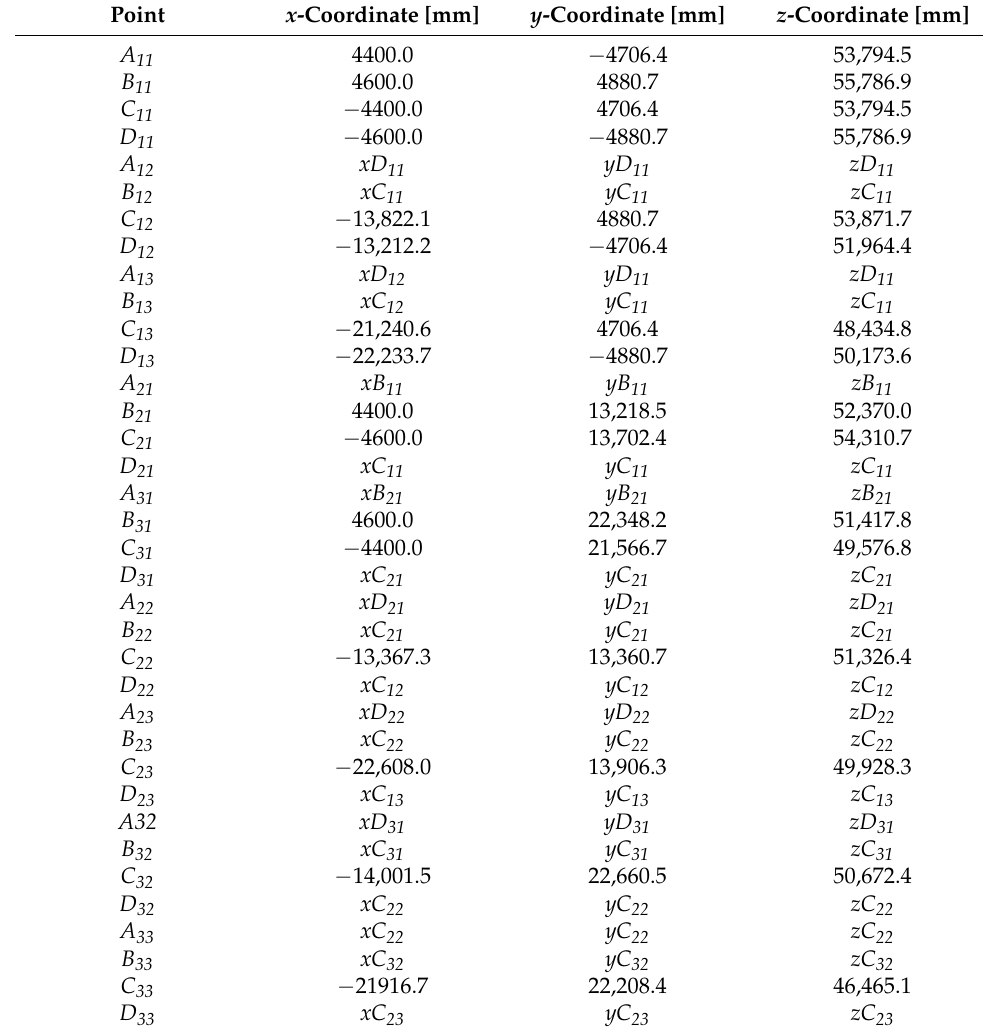
Table A6. The coordinates of the vertices A ij , B ij , C ij , D ij (for i, j = 1, 2, 3) of the basic configuration CB of the eaves edge net B v 1